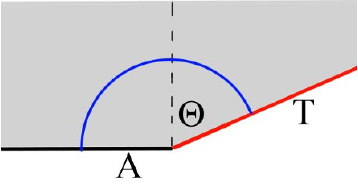
Figure 3 . An ETW brane with tension parameter T enters the bulk at coordinate angle (cid:2) in Fe(cid:11)erman-Graham coordinates. Larger T gives a larger angle (cid:2). Shown in blue is the RT surface computing the entanglement entropy of the subsystem A which includes the boundary. The area to the right of the dashed line is proportional to the boundary